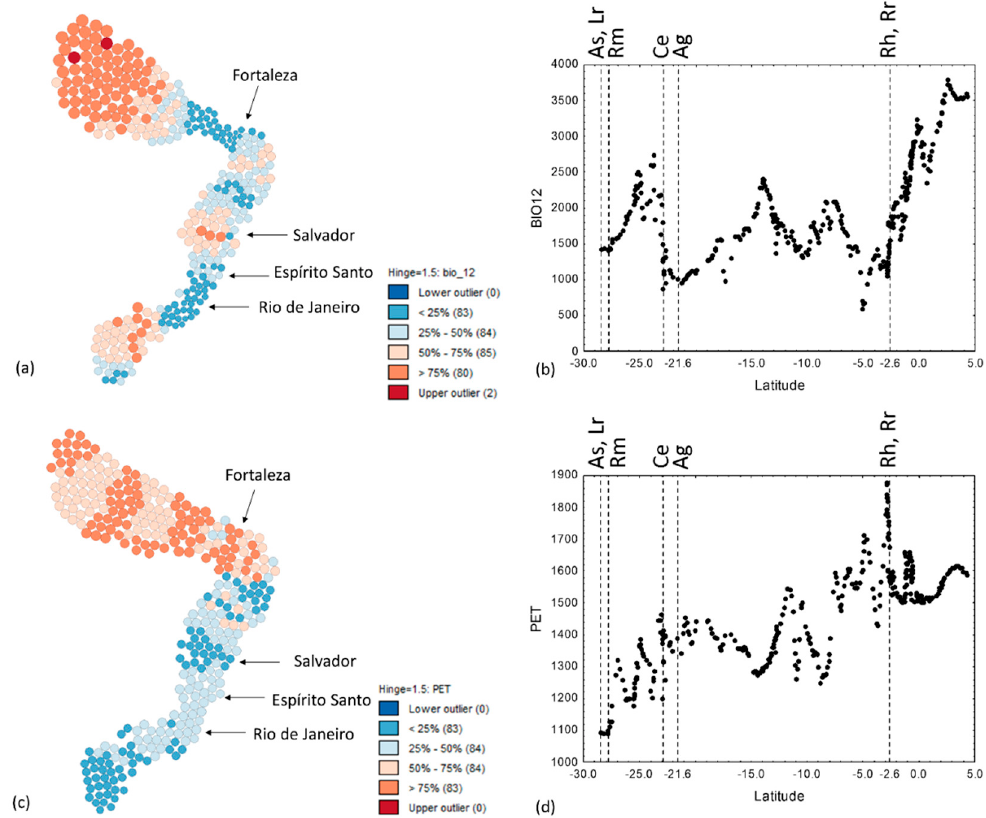
Figure 7. Detailed description of the Annual Precipitation (BIO12) and Potential Evapo-Transpiration (PET) for mangroves in Brazil. ( a ) The cartogram map distorted by the high and low values of BIO12; ( b ) Scatterplot ( n = 334) representing the BIO12 by latitude in decimal degree superimposed on species distribution limits (vertical dashed lines); ( c ) Cartogram map distorted by the high and low values of PET; ( d ) Scatterplot ( n = 334) representing the PET by latitude in decimal degree superimposed on species distribution limits. Refer to Figure 5 for further explanations.